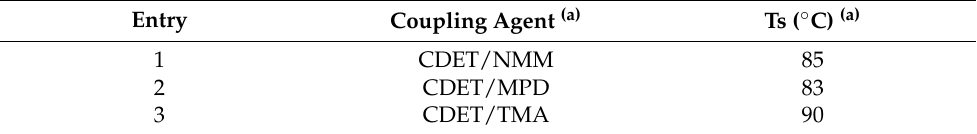
Table 3. Shrinkage temperature of collagen cross-linking by different CDET/ tert -Amine systems. Entry Coupling Agent (a)